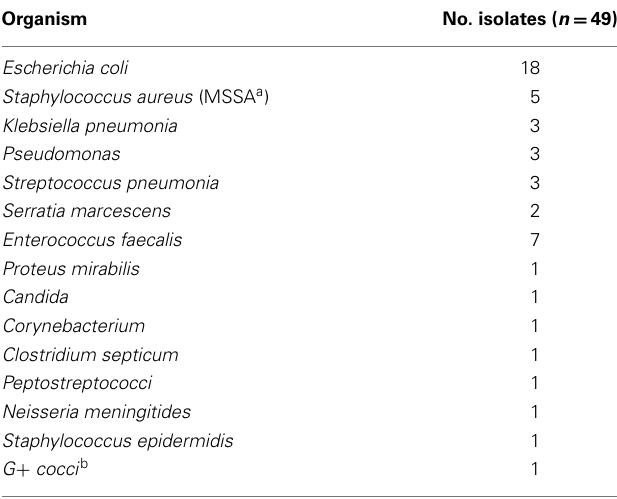
Table 2 | Microbiological findings of blood cultures